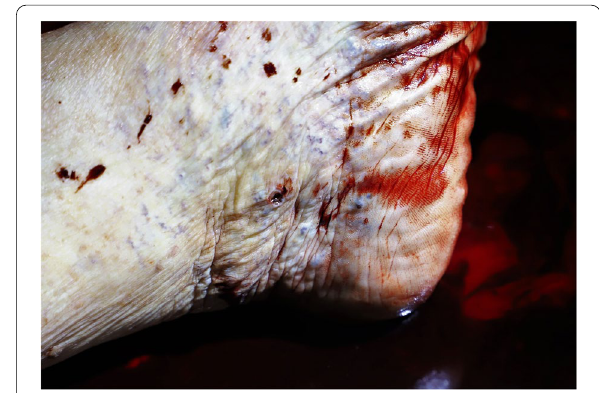
Fig. 4 Left medial malleolus with chronic venous disease and perforated varicose ulcer